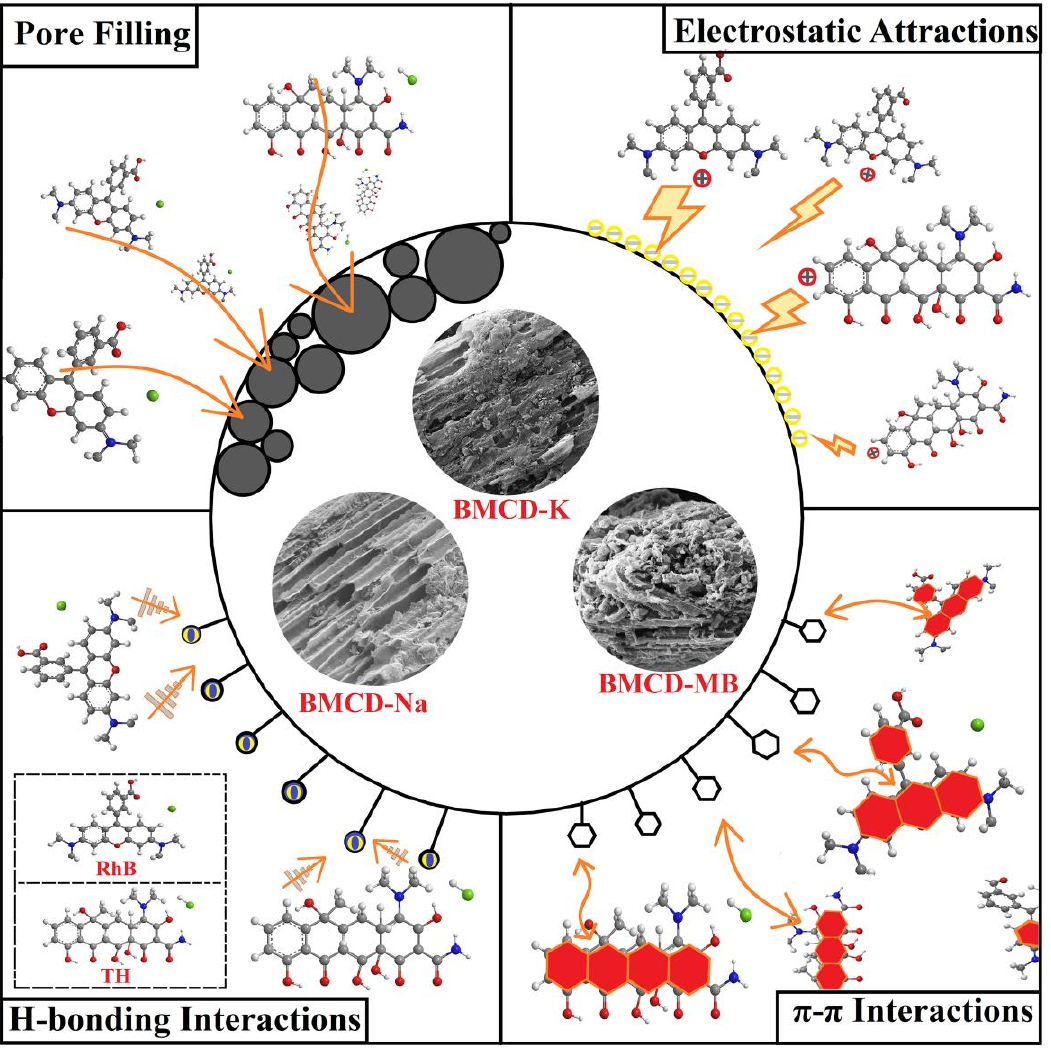
Figure 11. The probable adsorption mechanism diagram of BMCD-K, BMCD-Na, and BMCD-MB to RhB and TH.